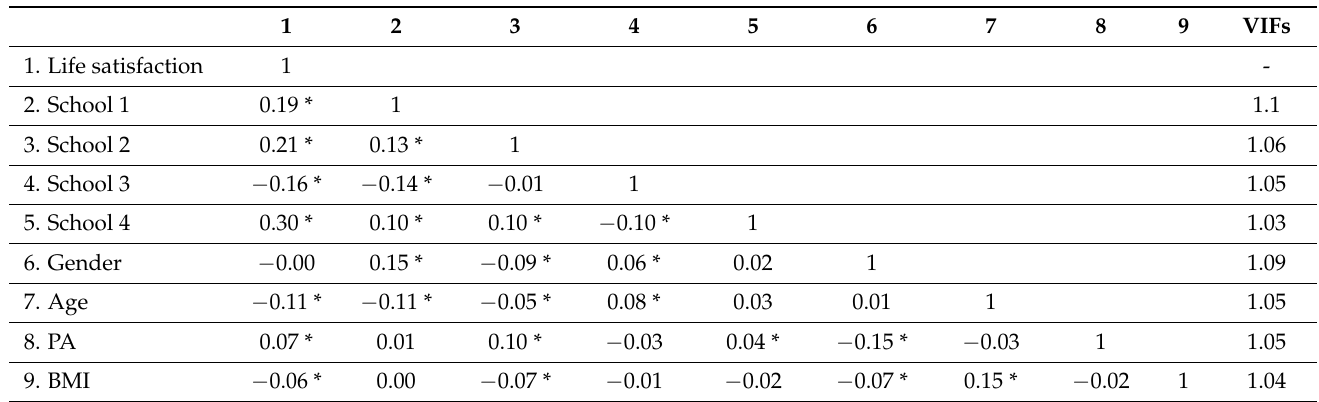
Table 2. Correlation coefficients and variance inflation factors (VIFs).